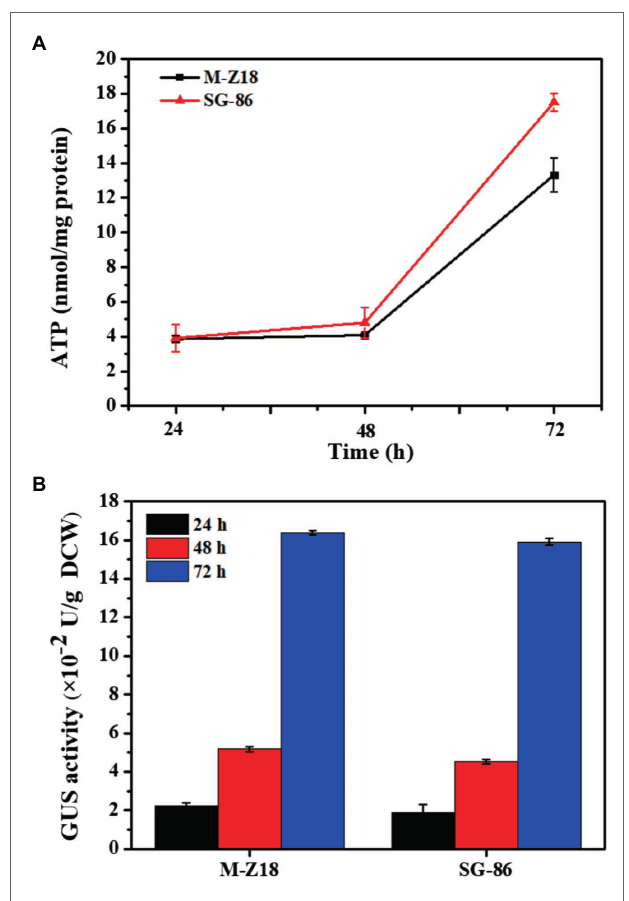
FIGURE 3 | Time-dependent changes of ATP involved in ε -PL biosynthesis in S. albulus M-Z18 and mutants SG-86 during shake flask fermentation (A) . Detection of b-glucuronidase activity. Glucuronidase activity was measured in cell lysates of parental strain S. albulus M-Z18 and mutant SG-86 from fermentation broth at 24, 48, and 72 h, respectively (B) .